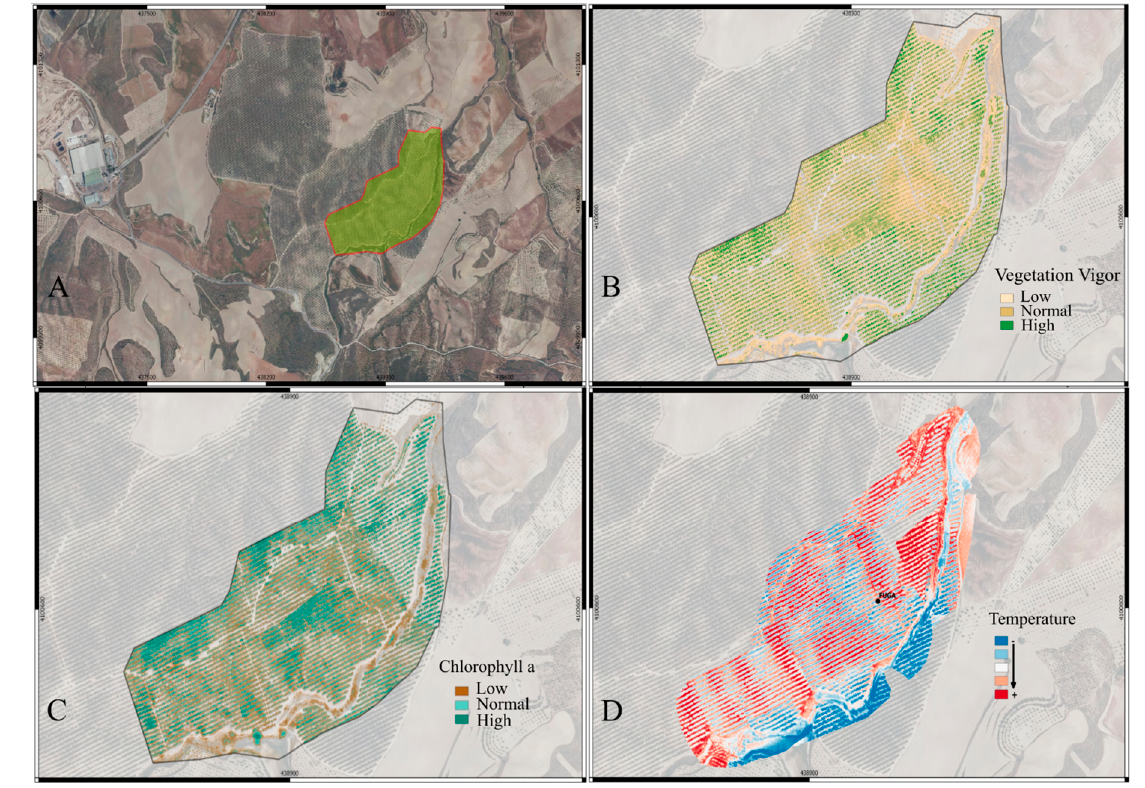
Figure 5. Images taken using multispectral ( A – C ) and thermal ( D ) cameras for olive crop using Yuneec Typhoon H hexacopter drone. (Images facilitated by MC Biofertilizantes).